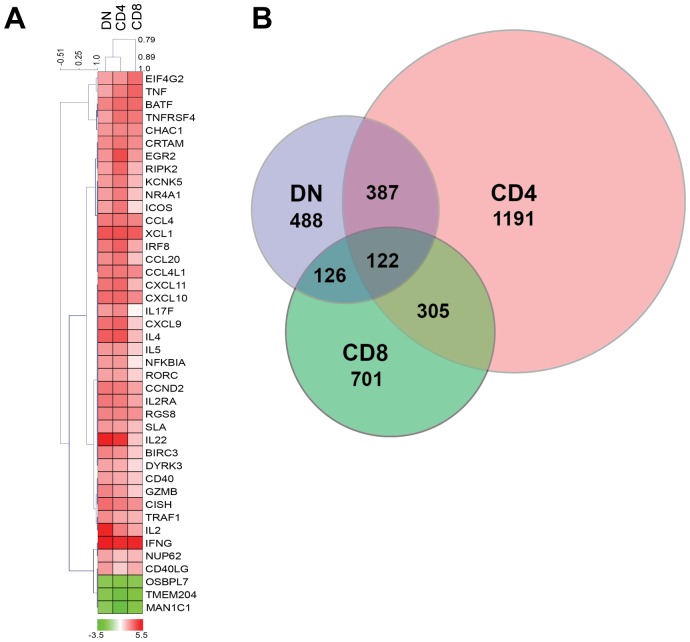
Transcriptome analysis utilizing microarray of stimulated CD4, CD8 and DN T cells from uninfected mangabeys demonstrates relatedness of CD4 and DN T cells.A) Heat map and hierarchical cluster analysis of genes that were differentially regulated over 4 fold are depicted for DN (lane 1), CD4 (lane 2) and CD8 T cells (lane 3). Red indicates upregulation and green indicates down regulation for each gene listed on the right. B) Venn Diagram representing overlap of differentially regulated genes (2 fold) identified from the microarray analysis of CD4, CD8 and DN T cells stimulated through their TCR (anti CD3/CD28).